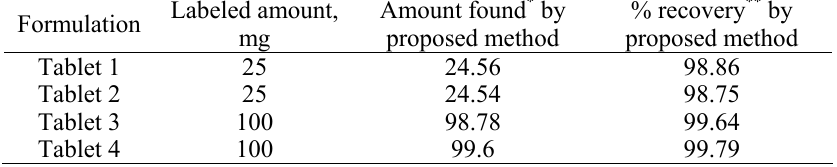
Table 2. Estimation of erlotinib hydrochloride in pharmaceutical formulations